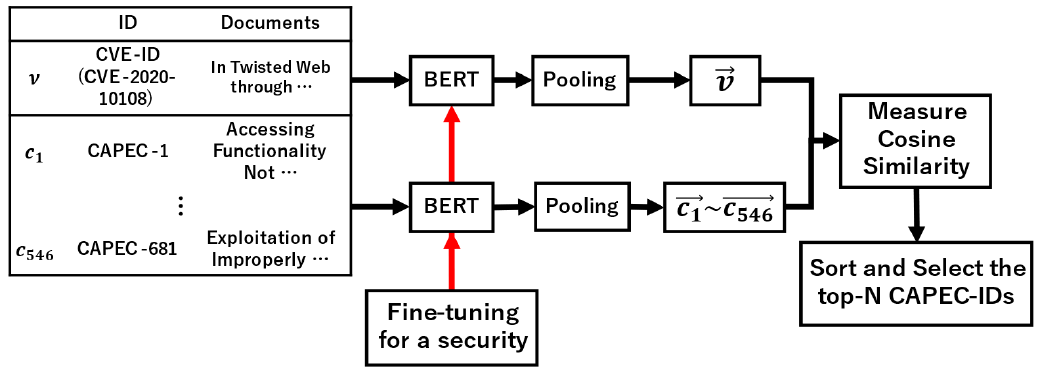
Figure 6. Overview of the tracing based on the Sentence BERT (SBERT) algorithm.